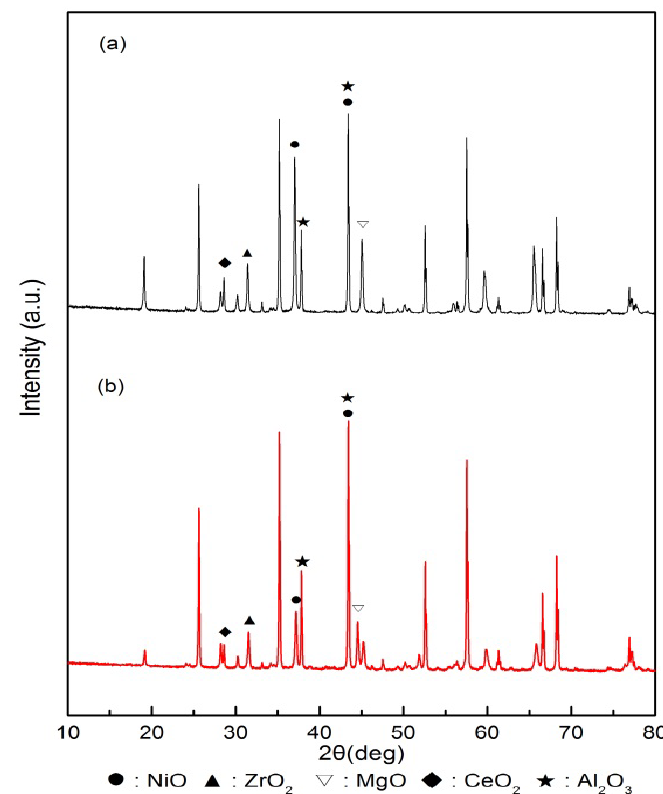
Figure 5. Preparation of the 3 wt% Ni-catalyst .